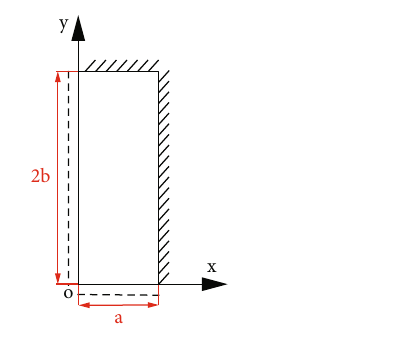
Figure 14: Mechanical model of large mining stope.